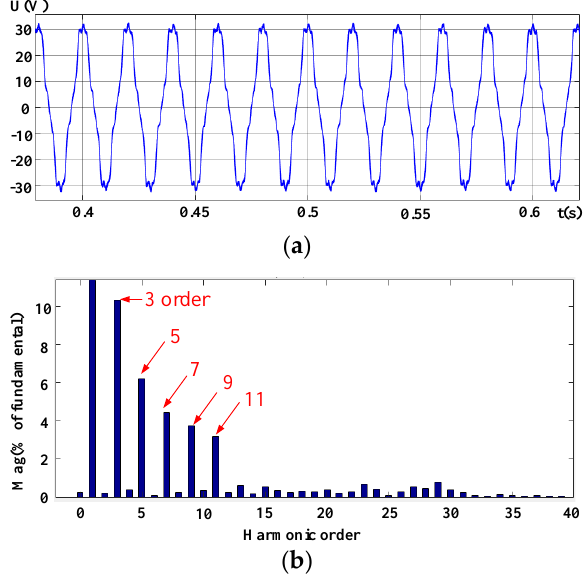
Figure 19. Grid current and THD analysis. ( a ) Grid current; ( b ) THD analysis (Fundamental component = 29.74 A, THD = 13.91%).